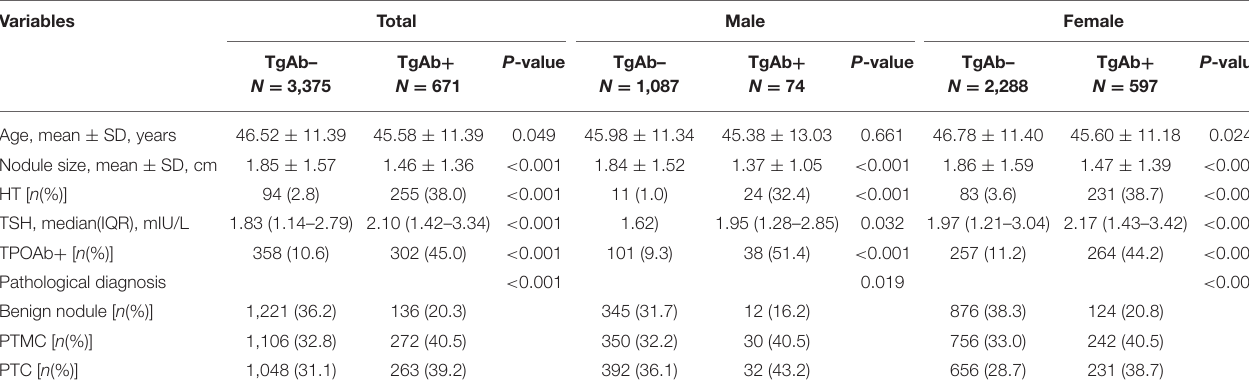
TABLE 2 | Characteristics of male and female TgAb-negative and TgAb-positive patients.